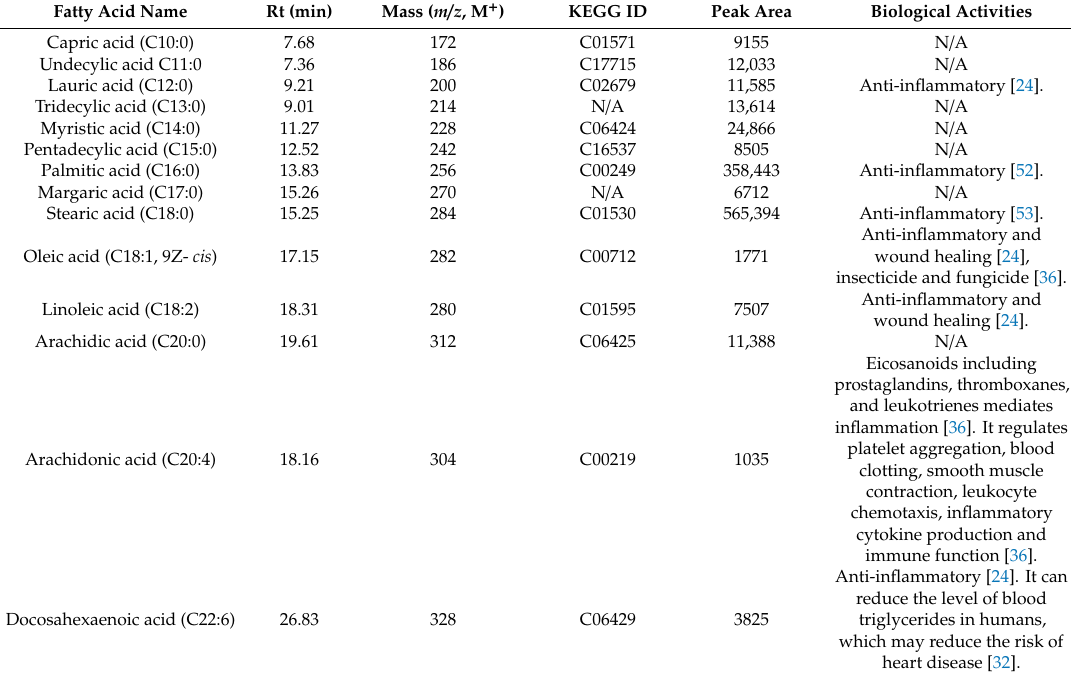
Table 2. Medium–long chain fatty acids (MLCFAs) identified from T. canis ESP using